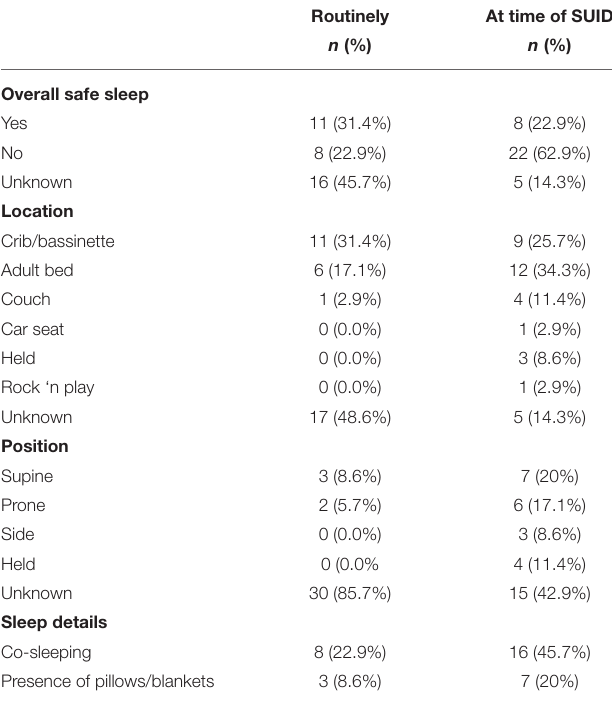
TABLE 2 | Overview of the infant sleep environment ( n = 35).